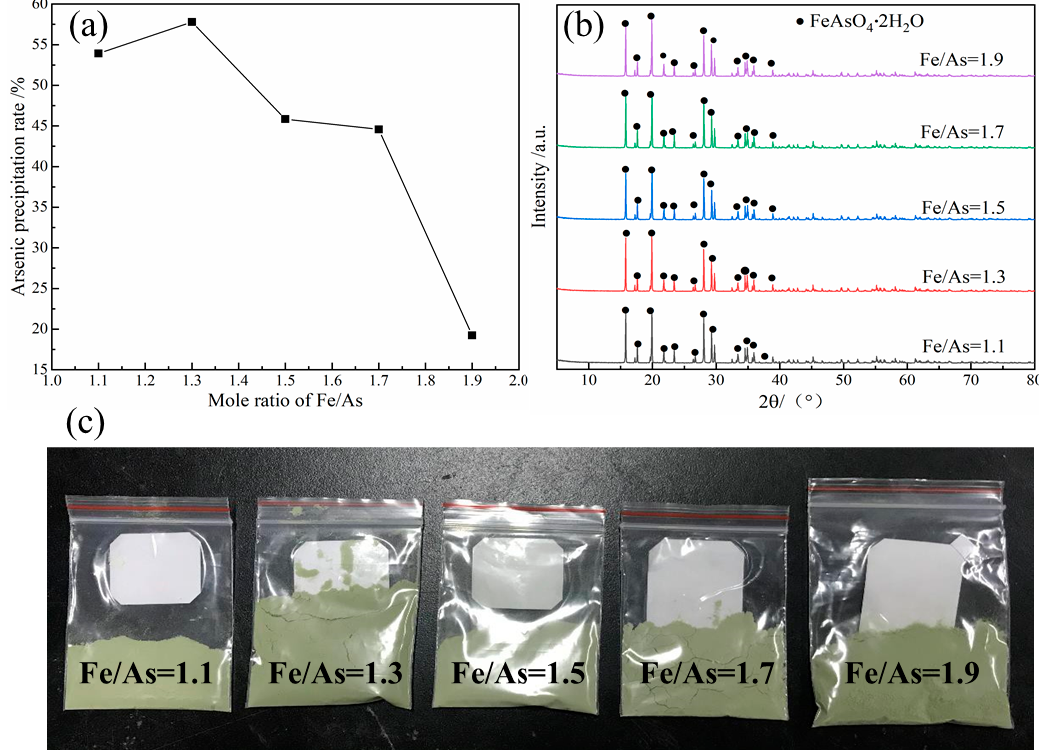
Figure 7. ( a ) Effect of initial Fe/As ratio on arsenic precipitation rate, ( b ) XRD patterns of precipitates obtained at different initial Fe/As ratio and ( c ) the appearance of precipitates obtained at different initial Fe/As ratio.